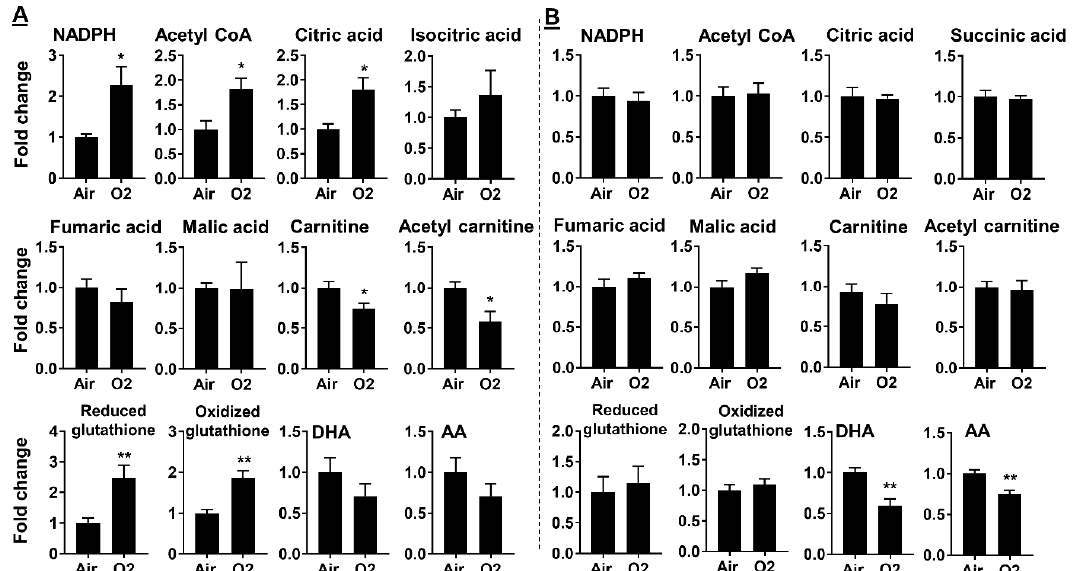
Figure 10. Neonatal hyperoxia dynamically altered metabolites for fatty acid synthesis and oxidation in mouse lungs. C57BL/6J mice (<12 h old) were exposed to hyperoxia (>95% O 2 ) or room air (21% O 2 ) for 3 days, and were allowed to recover in room air until pnd7 ( A ) or pnd14 ( B ). Lung metabolomics were measured using LC–MS. Data are expressed as mean ± SEM. n = 6. * p < 0.05, ** p < 0.01 vs. air. 2.4. Neonatal Hyperoxia Increased Oxidative Stress in Mouse Lungs at pnd7 but Not pnd14